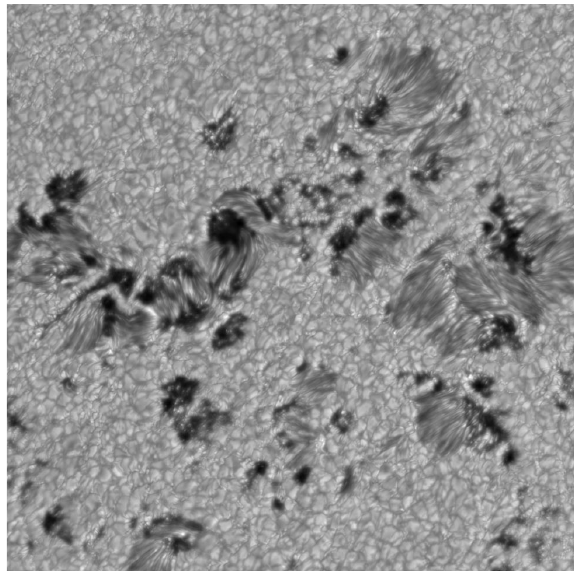
Fig. 3. White-light speckle reconstruction (520nm) of NOAA 8674 obtained on 27 August 1999 with the 65cm vacuum reflector at BBSO.